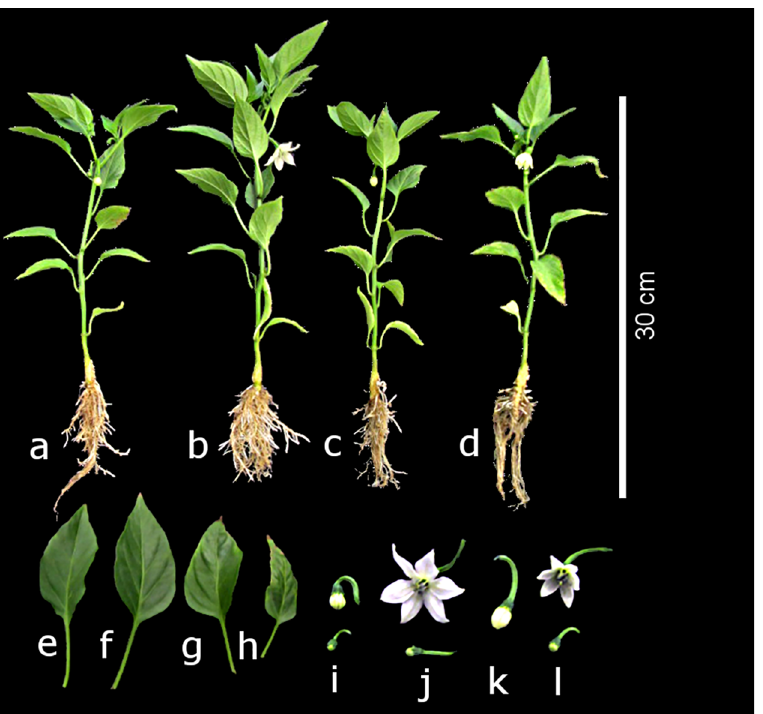
Fig 2. Growth and development displayed by pepper plants 28 days after treatment with different concentrations of vanadium (0, 5, 10 and 15 μ M V). Control: a, e, i; 5 μ M V: b, f, j; 10 μ M V: c, g, k; and 15 μ M V: d, h, l.